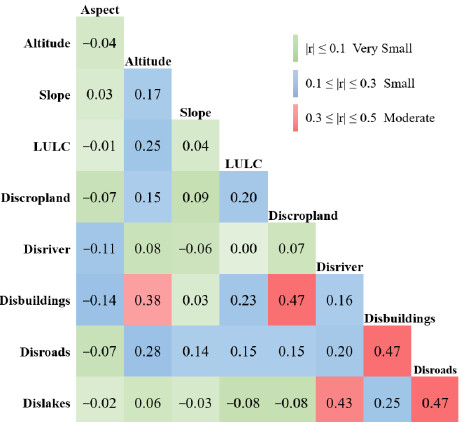
Figure A3. Pearson’s correlation (r) test for every environmental variable using Cohen’s 1988 rule to determine the significance level.